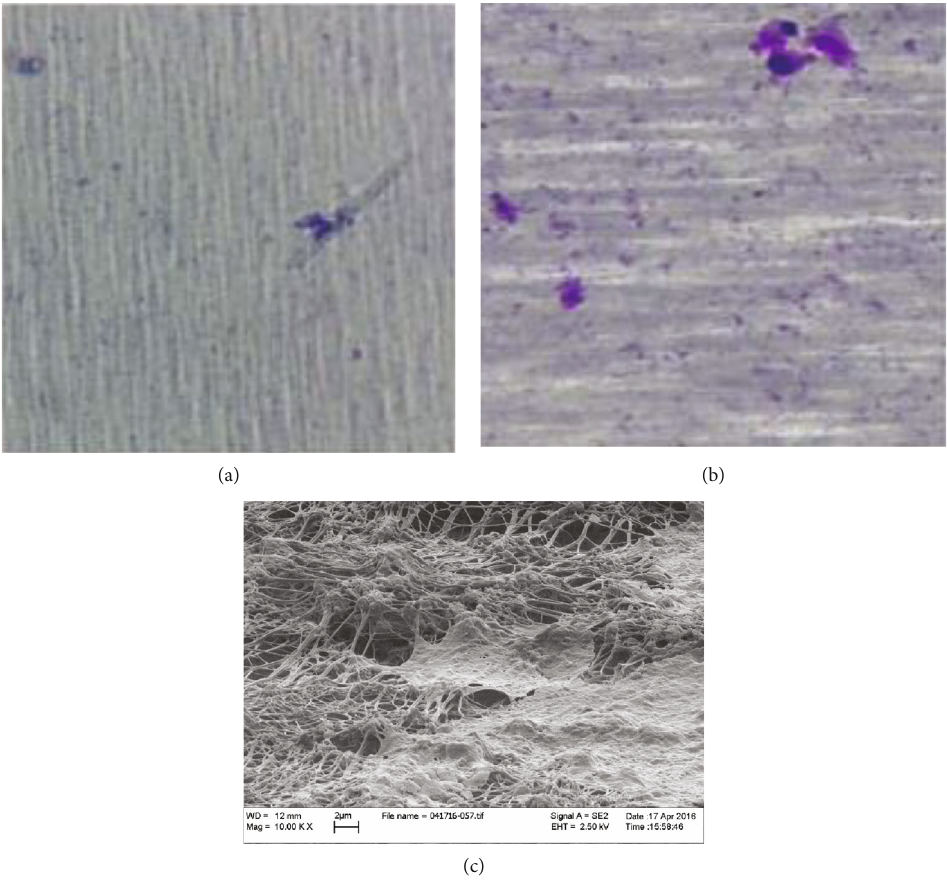
Figure 3: Representative image of migrated GMSCs in lower compartment of 3 microns pores perforated collagen-coated PTFE membranes with GMSCs from (a) in fl amed tissues and GMSCs from (b) healthy tissues. (c) SEM image showing migrated GMSCs passing through 3 microns pores of perforated collagen-coated PTFE